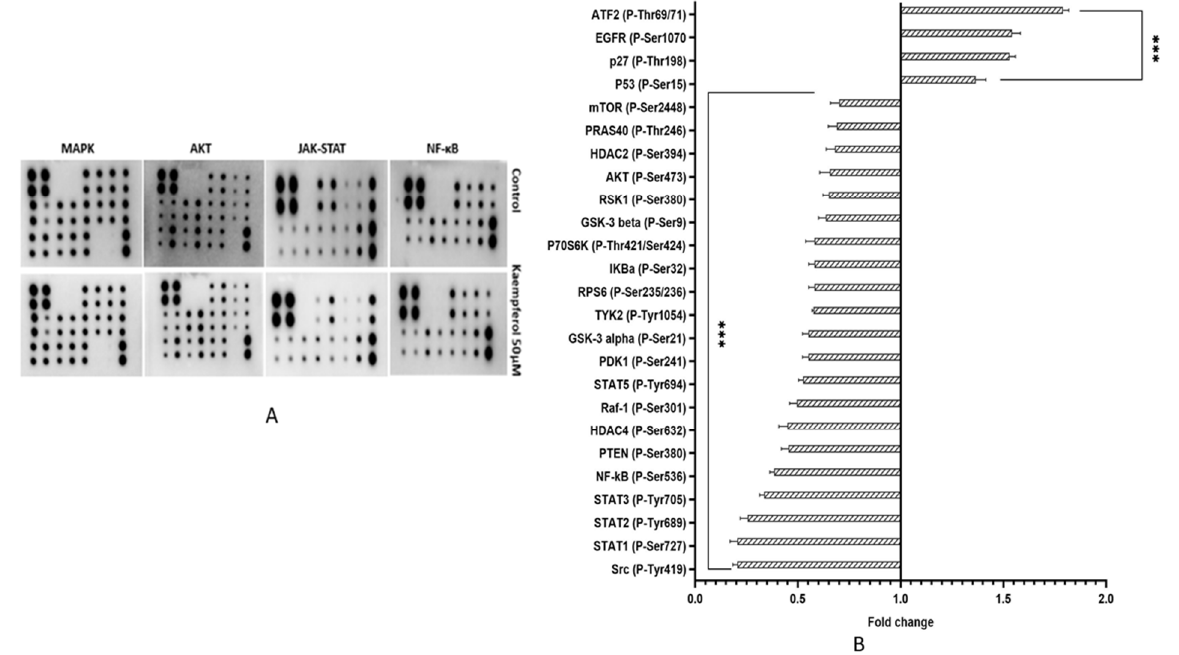
Figure 6. Analysis of phosphorylated proteins involved in signalling pathway. ( A ) Images of nitro- cellulose membranes exhibiting differential expression of the phosphorylated proteins involved in MAPK, AKT, JAK-STAT and NF- ĸ B pathways after kaempferol treatment (50µM of for 48 h) com- pared to control. ( B ) Bar graph showing reduced expression of various molecular markers associ- ated with the aforementioned pathways, while the expression of P53 (p-ser241) and P27 (p-Thr198), ATF2(P-Thr69/71) and EGFR (P-Ser1070) were upregulated. Fold change showing the expression of different proteins. Data is presented as the mean ± standard deviation of three independent experi- ments *** p < 0.001.